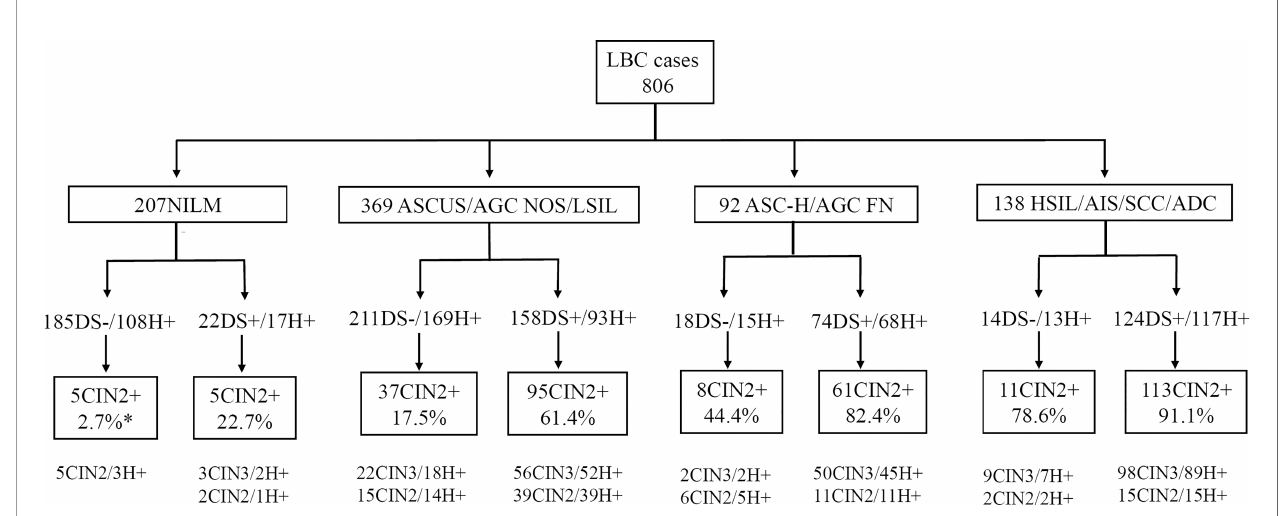
FIGURE 1 | Graphic overview of patient test results in this study. *CIN2+ cases/DS positive or negative cases. DS, p16/ki-67 dual-staining; H+, positive for HR HPV; LBC, liquid-based cytology; ADC, adenocarcinoma; AGC FN, atypical glandular cells, favor neoplastic; AGC NOS, atypical endocervical cells, not otherwise speci fi ed; AIS, adenocarcinoma in situ ; ASC-H, atypical squamous cells cannot exclude high-grade squamous intraepithelial lesion; ASCUS, atypical squamous cells of undetermined signi fi cance; CIN, cervical intraepithelial neoplasia; CIN2+, cervical intraepithelial neoplasia grade 2 or worse; CIN3+, cervical intraepithelial neoplasia grade 3 or worse; HSIL, high-grade squamous intraepithelial lesion; LSIL, low-grade squamous intraepithelial lesion; NILM, negative for intraepithelial lesions or malignancy; SCC, squamous cell